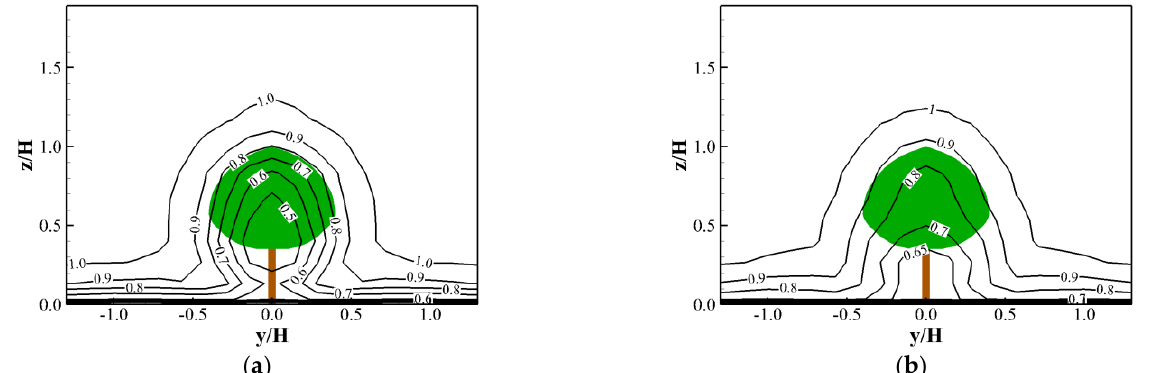
Figure 6. Measured mean velocity profiles at ( a ) x = 3 H and ( b ) x = 4.5 H. Parallel flow simulations were conducted using a number of tentative selections of the crown factors (C Da ). By comparing the predicted downstream velocity profiles with the measured ones, the C Da value, leading to the best agreement, was then determined.